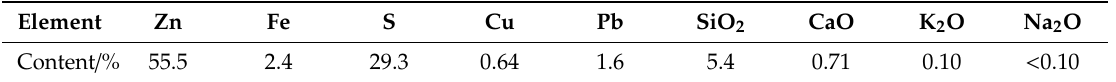
Table 1. Chemical composition of the ZnS